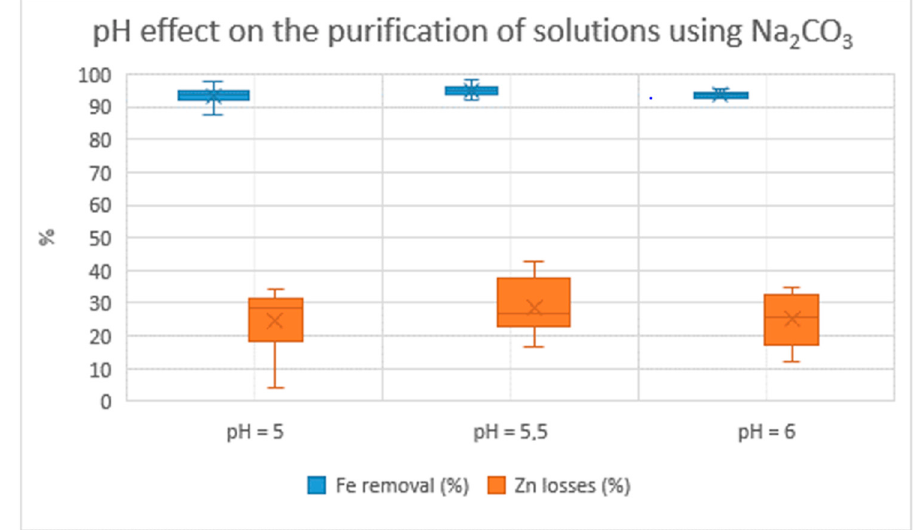
Figure 15. pH effect on the purification of solutions using Na 2 CO 3 .